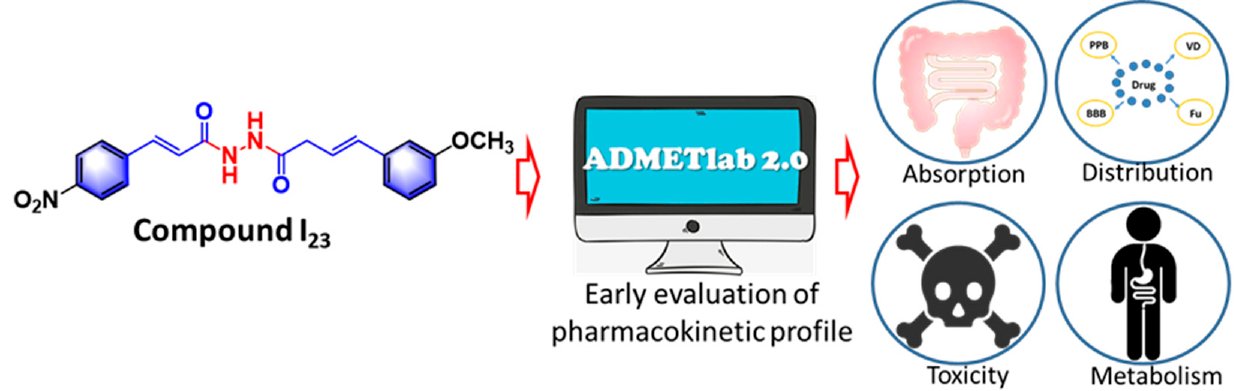
Figure 10. The predicted model of pharmacokinetic profile for compound I 23 .